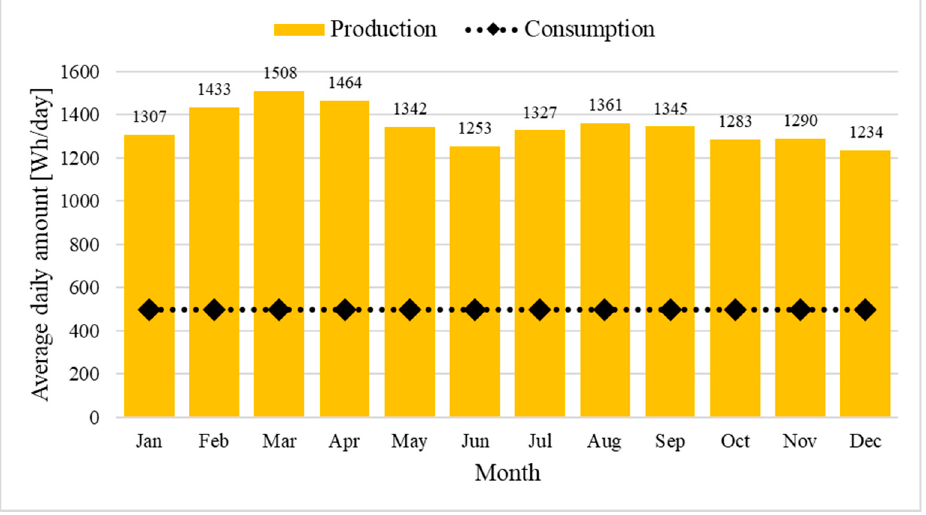
Figure 8. Typical daily performance of a PV-based system installed in Río Abajo